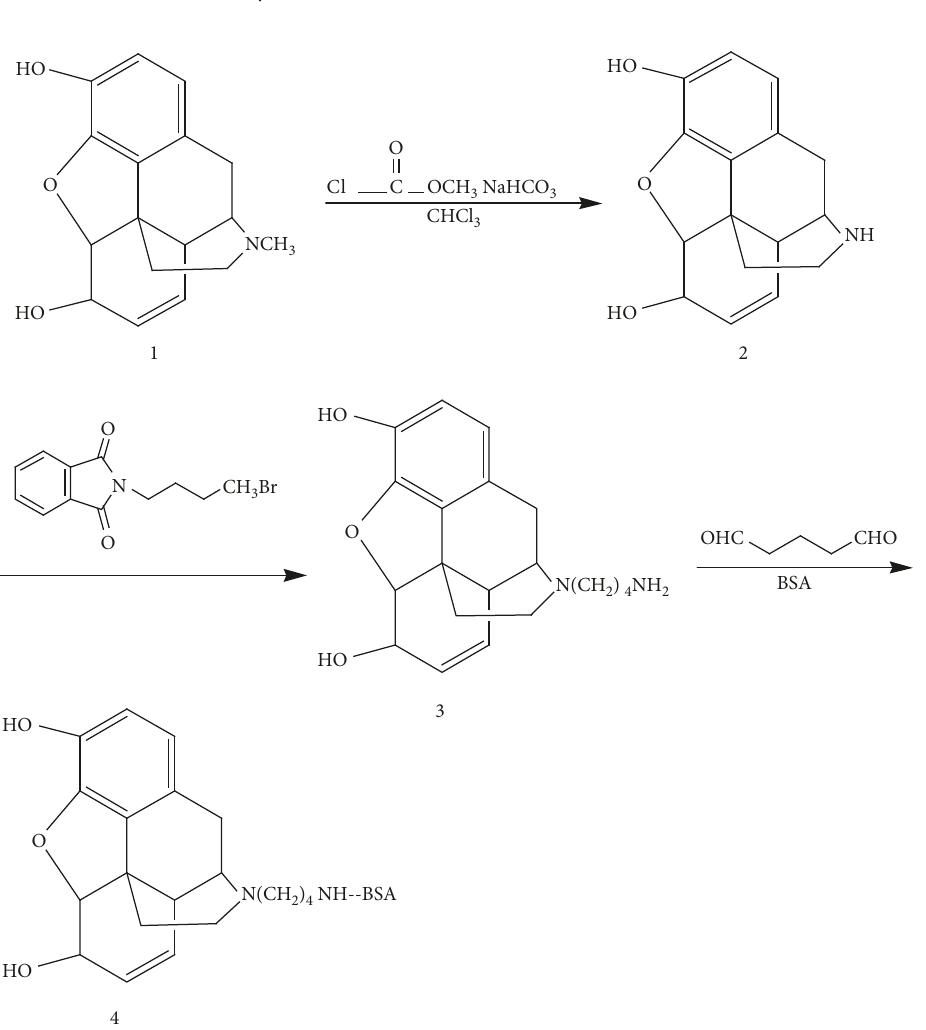
Figure 1: Synthesis reaction process of MOR hapten